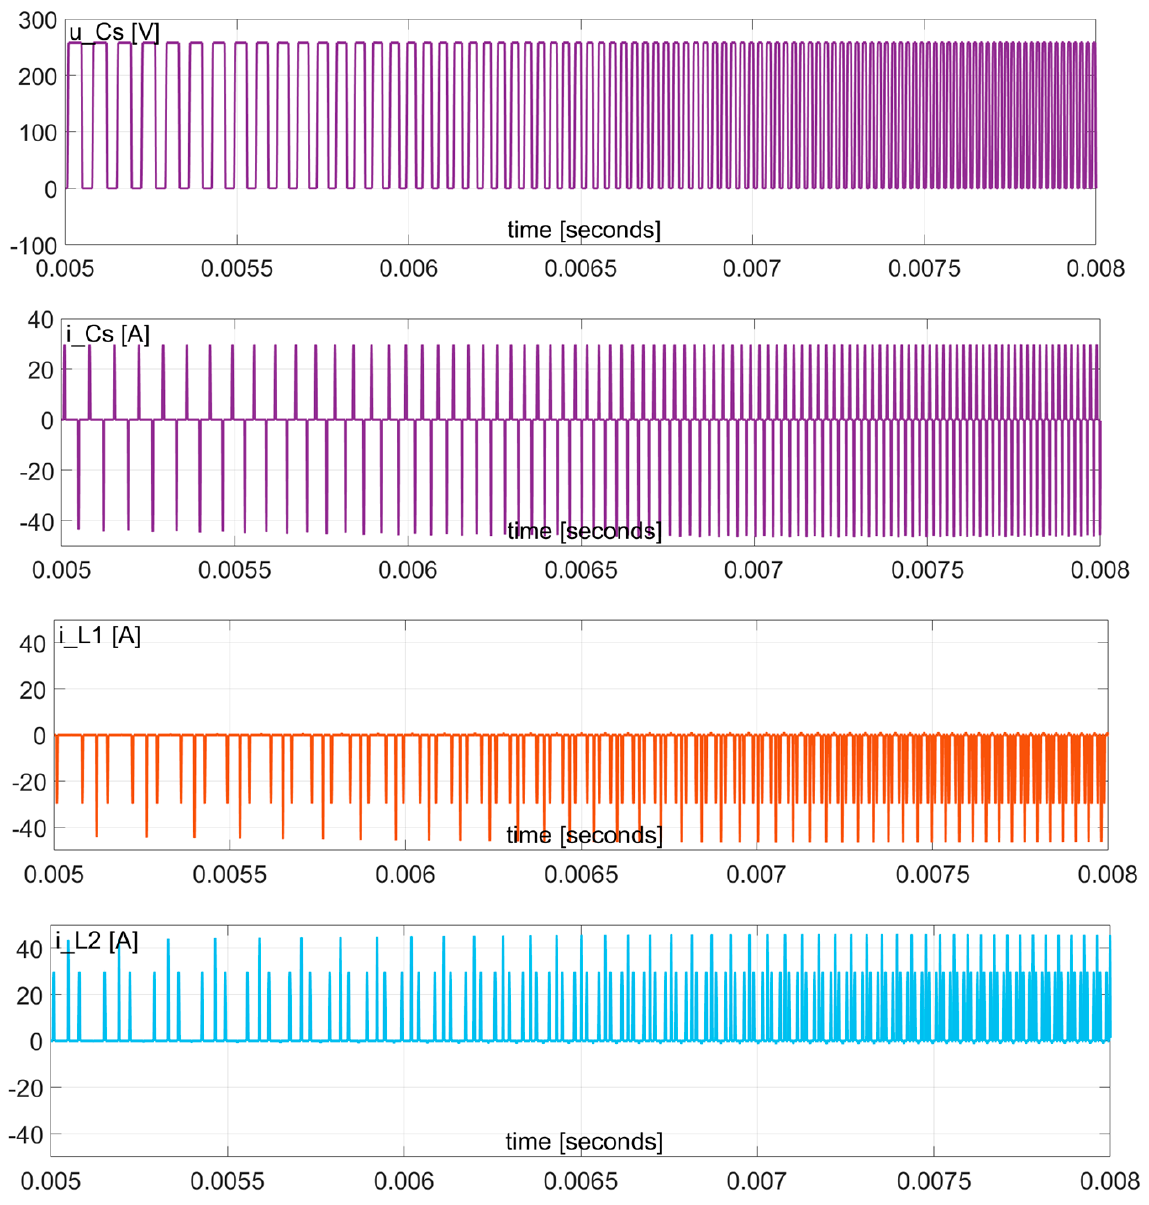
Figure 16. Steady state waveforms of the AIVB components at controlled switching frequency. Voltage and current of the switched capacitor as well as currents of resonant chokes. 500 µ s/div.